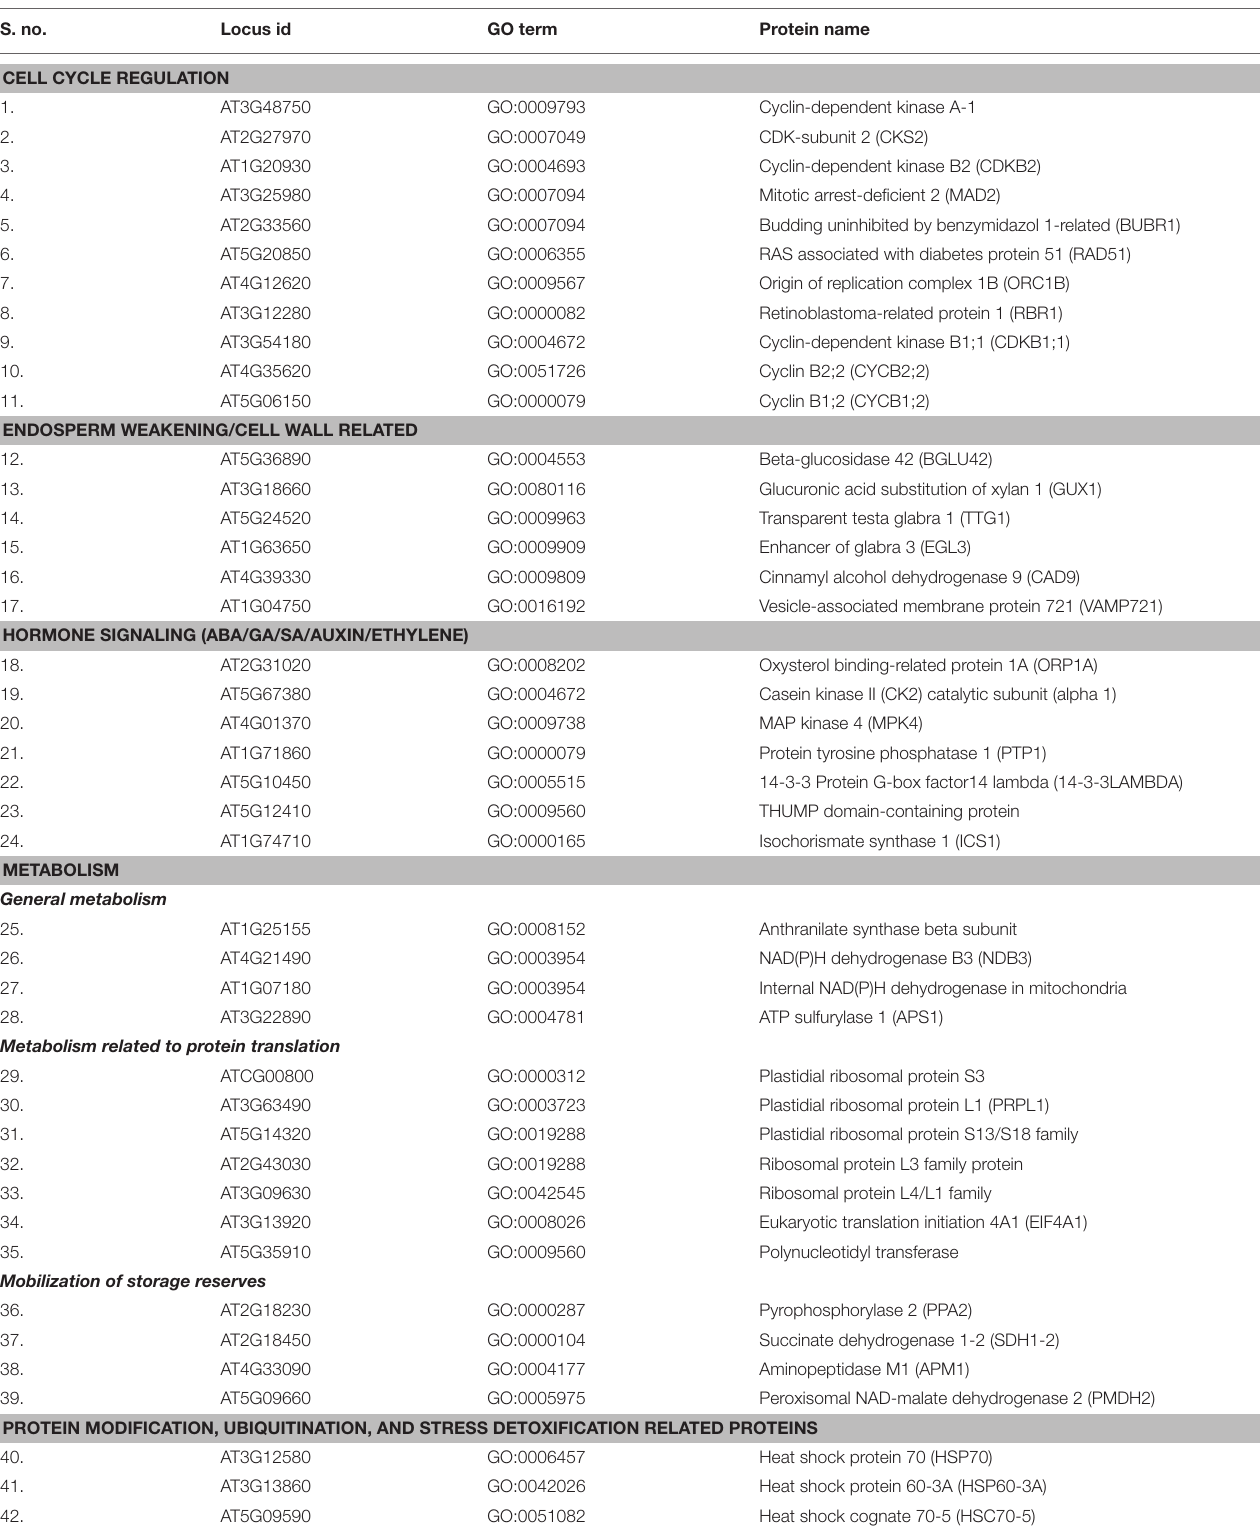
TABLE 1 | Central proteins identified from Podophyllum germination network, critically important for radicle protrusion step of seed germination mechanism. S.